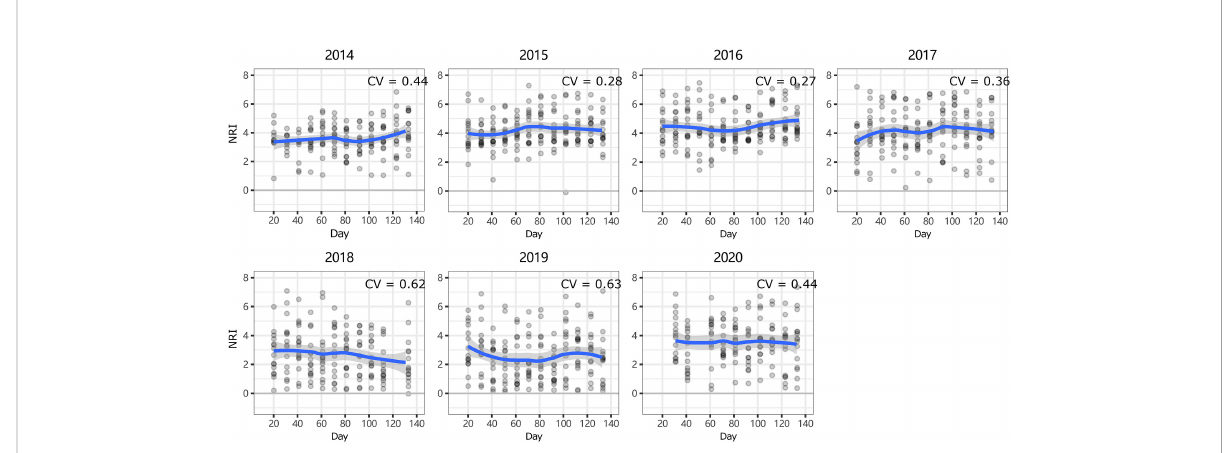
FIGURE 5 Intra-annual dynamics of community phylogenetic structure at the Xilinhot National Climate Observatory (NCO) in Inner Mongolia, China. The ordinate shows the net relatedness index (NRI). The abscissa shows the number of days since May 1. The blue line indicates the model prediction. The gray area shows the 95% con fi dence interval around the